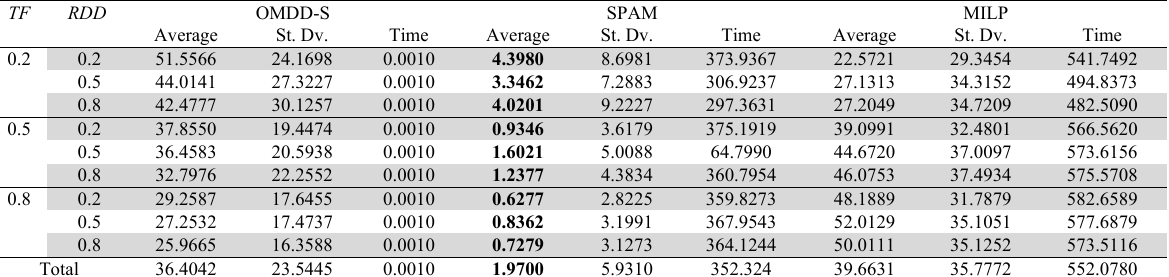
Small-sized test instances: RDI values for TF and RDD (part 2)